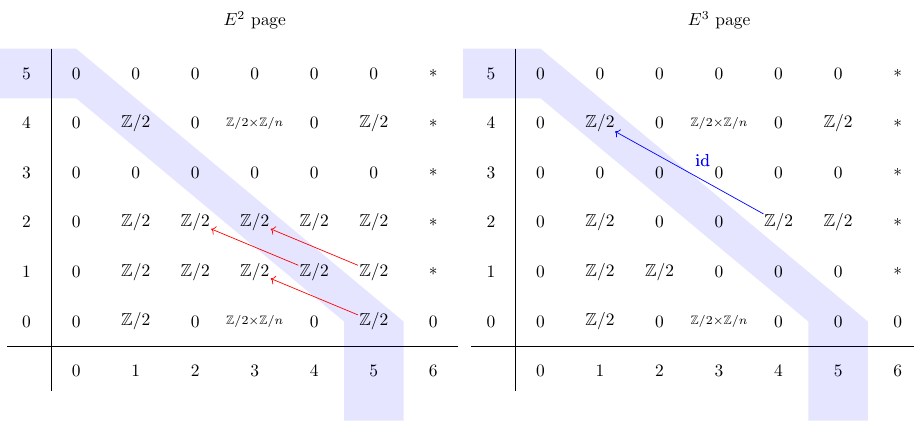
˜Ω Spin ( BD ) with odd n 2 n d